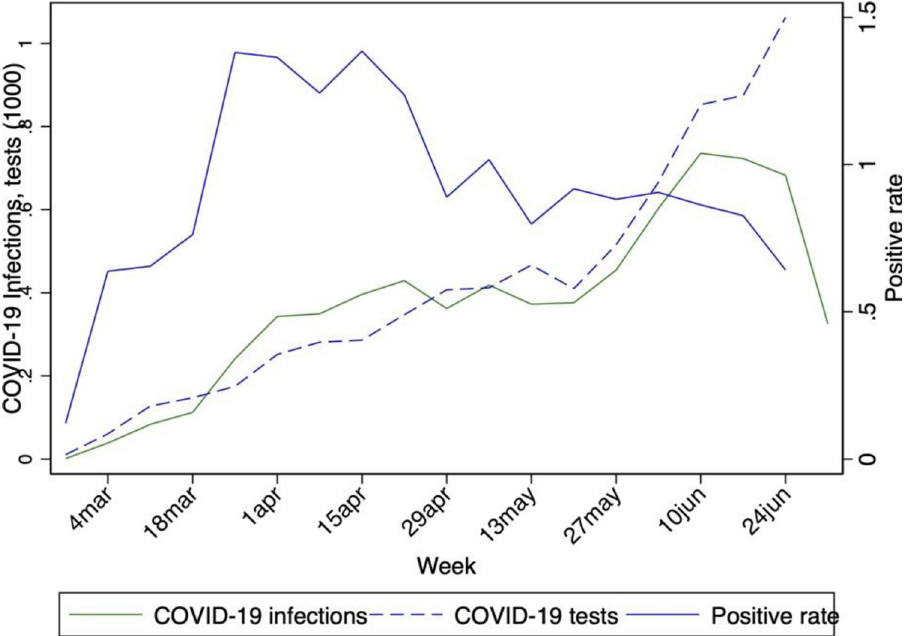
Fig 2. Weekly number of infections and weekly number of tests in Sweden. Notes : The figure shows the weekly number of infections, the weekly number of tests, and the positive rate in Sweden up to June 22. Data source: ECDC and Our World in